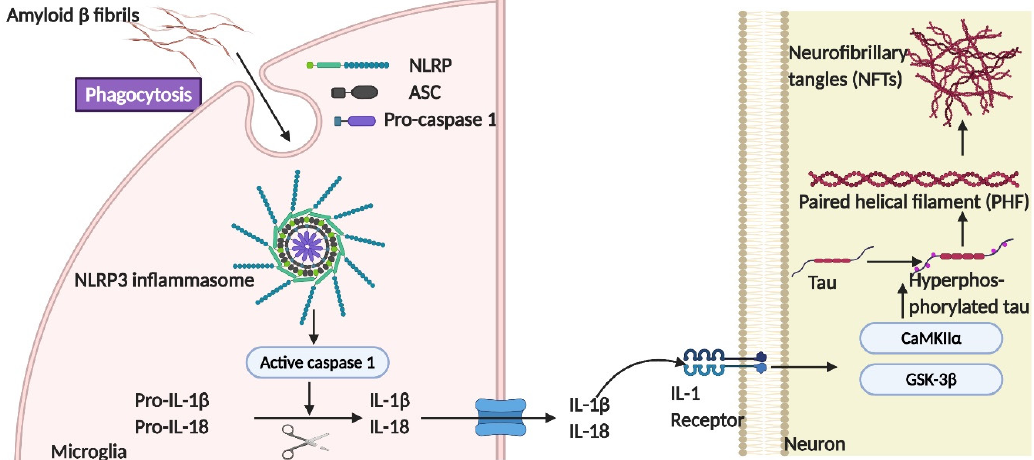
Figure 5. The role of the NLRP3-ASC inflammasome in tau pathogenesis. Either fibrillary A β or tau species in the form of monomers or oligomers are sufficient to induce the assembly of the NLRP3 inflammasome, consisting of NLRP3, ASC, and pro-caspase 1, which further leads to caspase 1-dependent release of the pro-inflammatory cytokines IL-1 β and IL-18 [85]. The activation of the NLRP3 inflammasome in microglia has been demonstrated to promote neuronal tau hyperphosphorylation in an IL-1 receptor-dependent manner via the regulation of multiple tau kinases, like GSK-3 β and CaMKII- α .